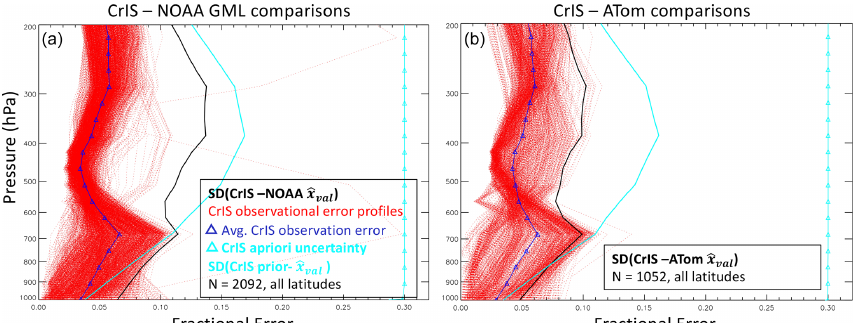
Figure 11. Error comparison of CrIS observational error estimates and the standard deviation (SD) of CrIS ˆ x val (in black) for NOAA GML flights (a) and ATom flights (b) . Single-profile CrIS observational error estimates are plotted in red, with the average in dark blue with triangles. For reference, and the standard deviation of CrIS prior with aircraft ˆ x val is in cyan, and the a priori fractional uncertainty (0.3) is shown in cyan with triangles.